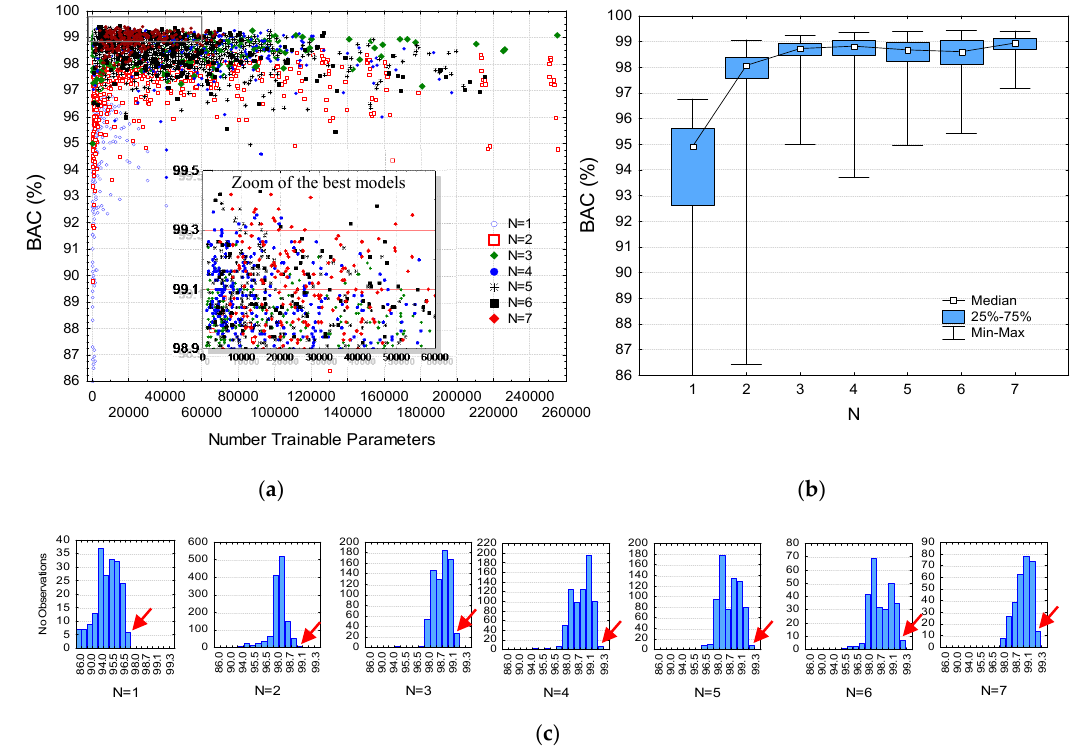
Figure 4. Analysis of validation balanced accuracy (BAC) performance for all CNN models trained with random search: ( a ) scatterplot of BAC in function of the number of trainable parameters; ( b ) box plots of BAC categorized to the network depth N = {1, 2, 3, 4, 5, 6, 7}; ( c ) BAC histograms categorized to N and highlighting the selected models with top-ranked performance (red arrow).